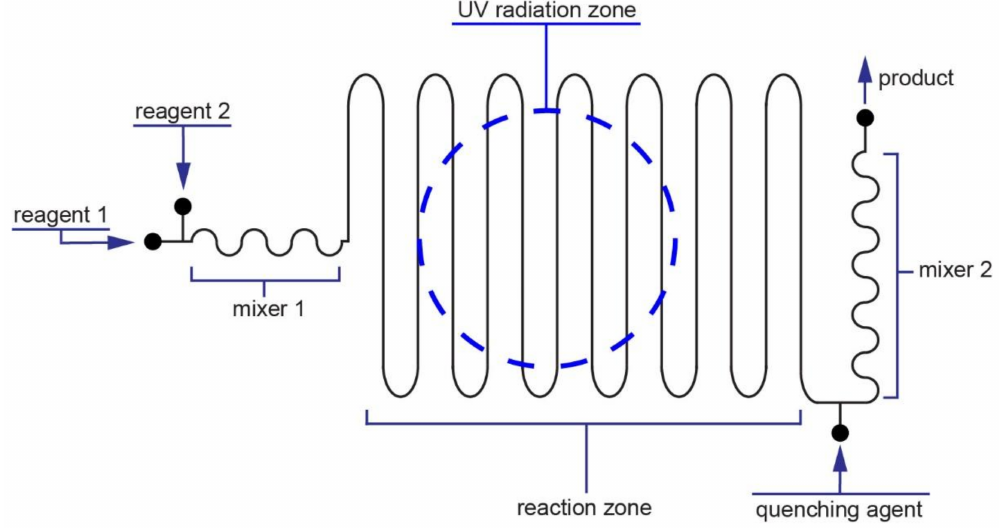
Figure 2. Schematic diagram (without maintaining the scale) of the FEP microreactor used in experiments. Microreactor consists of: two inlets for reagents, mixer for initial mixing reagents, main reactor where ultraviolet (UV) radiation affects reagents, and finally inlet for quenching reagent together with mixer. The precise computer aided manufacturing (CAM) schematic of the microreactor is shown in Figure